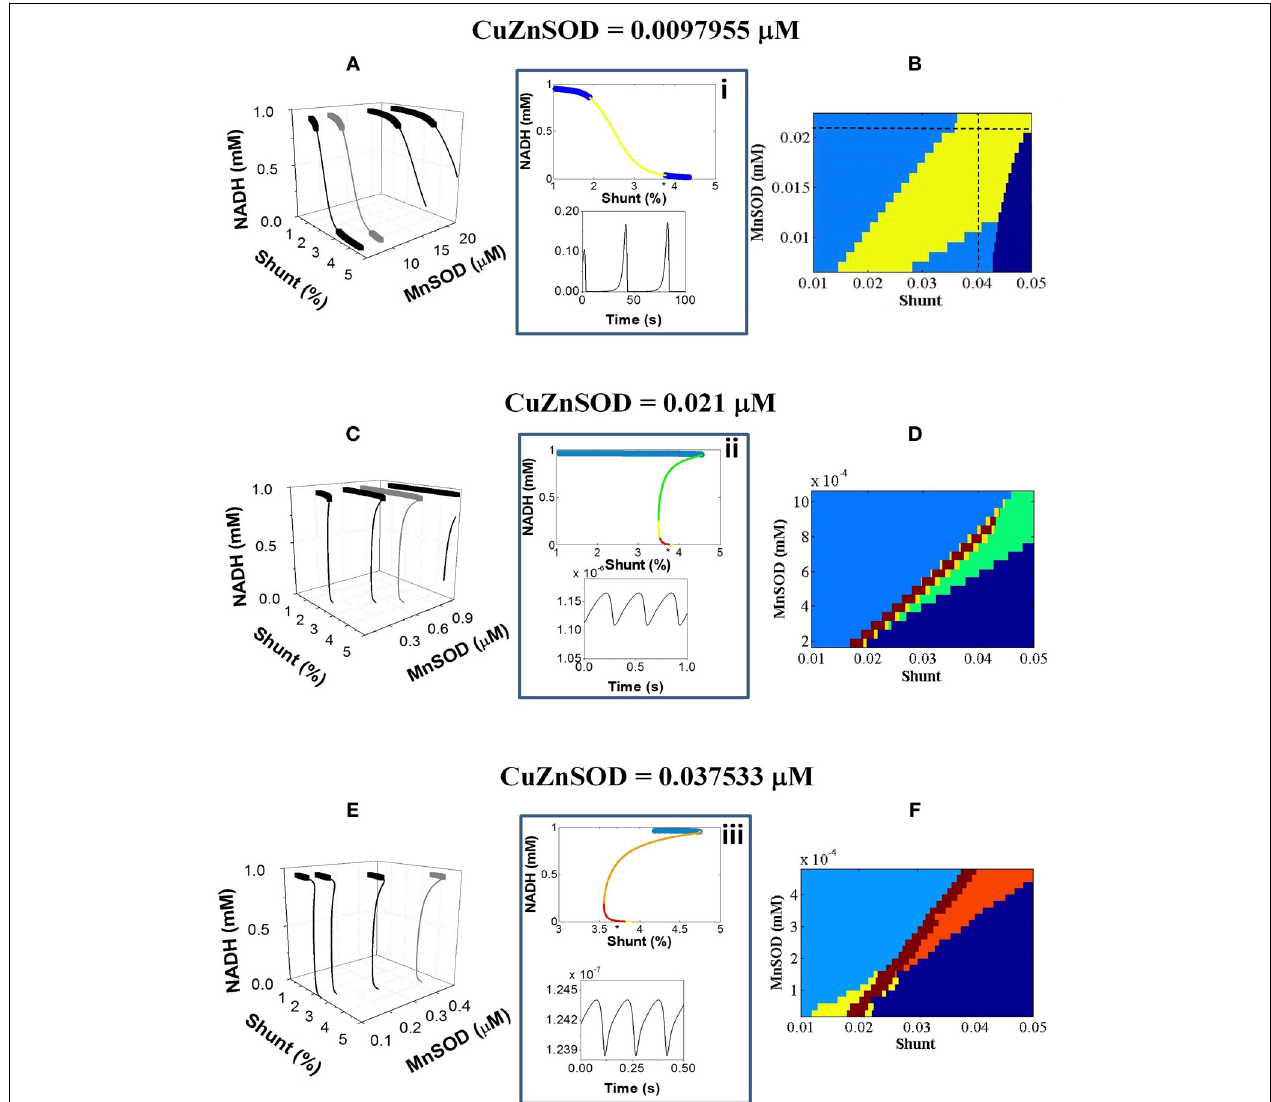
FIGURE 2 | NADH dynamic behavior as a function of mitochondrial ROS production and scavenging, at different antioxidant capacity of the extra-mitochondrial compartment. The model behavior was analyzed by stability analysis as described in Methods. (A,C,E) Depicted are the bifurcation diagrams showing an upper branch of steady states in which NADH is predominantly reduced, and a lower branch in which NADH is mainly oxidized. Thick lines correspond to stable steady-state behavior whereas thin lines denote stable limit cycle (oscillatory) behavior and an unstable focus. Hopf bifurcations mark the transition from steady to oscillatory dynamics. Further analysis of the eigenvalues obtained in the stability analysis enabled a detailed description of the oscillatory region. Insets i–iii depict an example of eigenvalues for the bifurcation diagrams shown in gray in the panels (A,C,E) at the left. Information of the maximum eigenvalue observed for a given parametric combination is represented in the